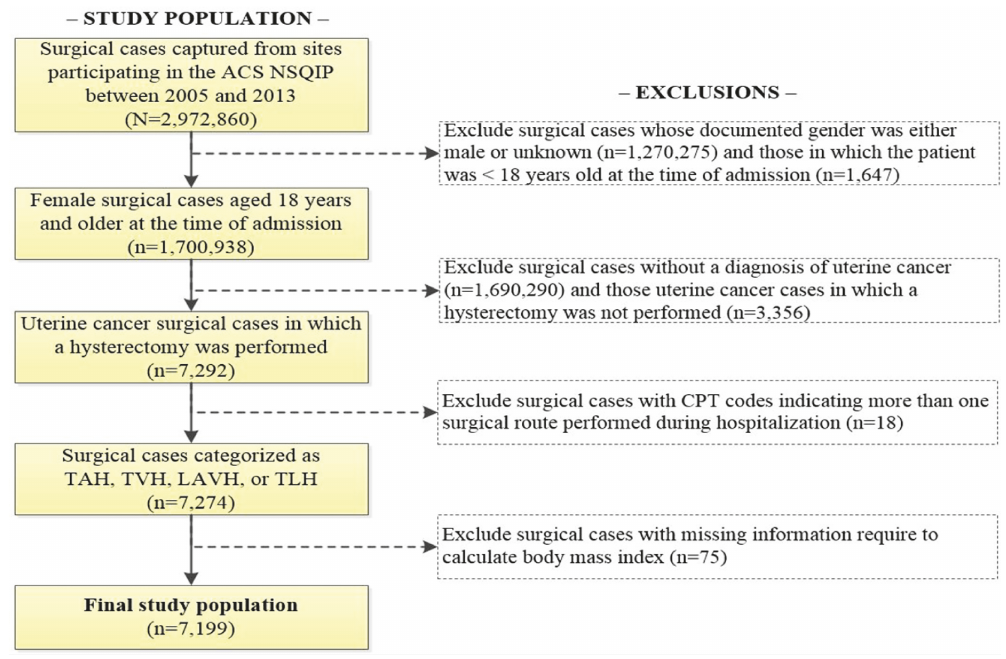
Figure 1: Flow diagram representing thefinal determination of all patients in which a hysterectomy was performed among patients with a diagnosis of uterine cancer, ACS-NSQIP, 2005-2013 . ACS-NSQIP: American College of Surgeons-National Surgical Quality Improvement Program; TAH: total abdominal hysterectomy; TVH: total vaginal hysterectomy; LAVH: laparoscopic assisted vaginal hysterectomy; TLH: total laparoscopic